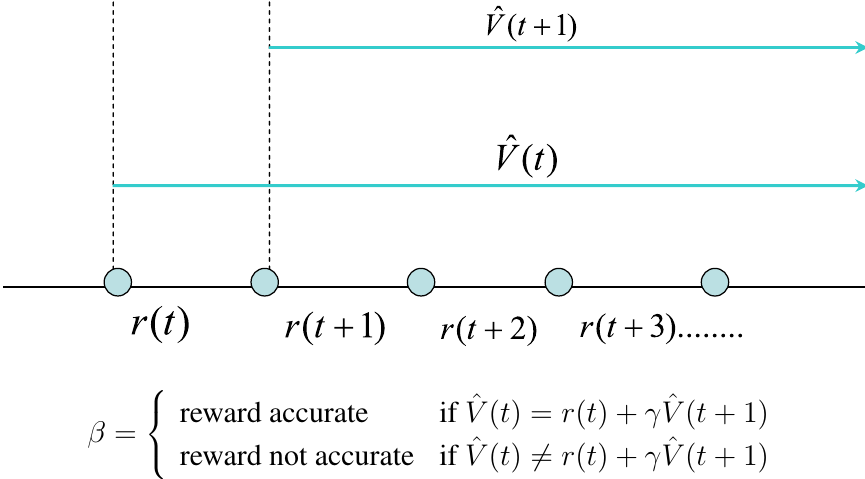
Figure 1. Temporal difference based learning to